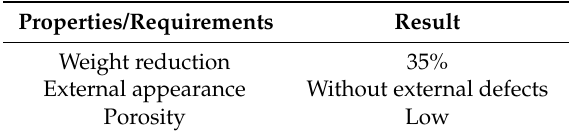
Table 2. Requirements established for magnesium-aluminium foam-based rod.